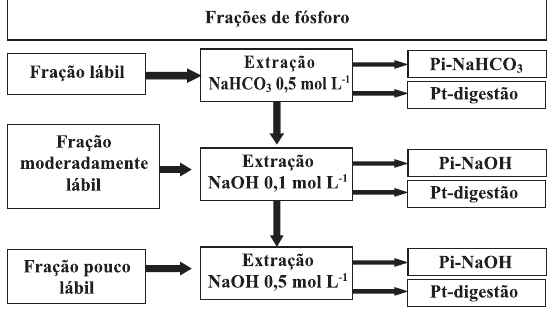
Figura 1. Fluxograma operacional de frações de fósforo, adaptado de Hedley et al.